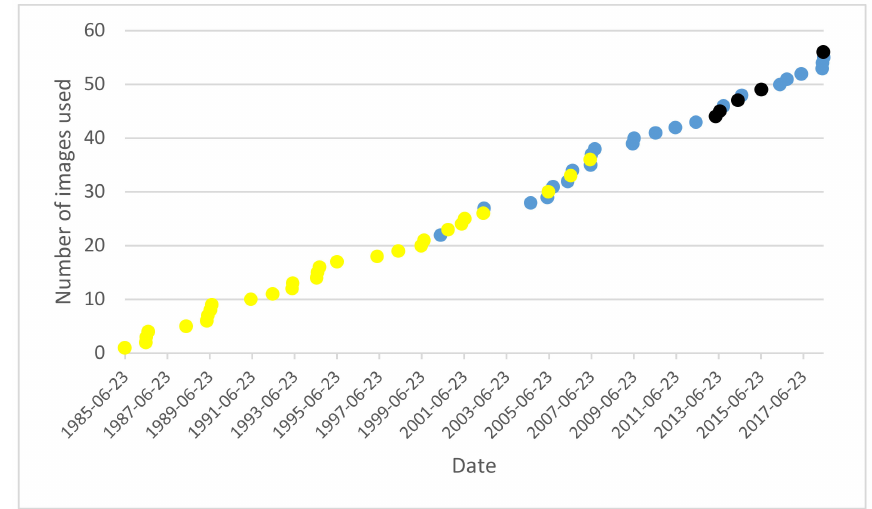
Figure 2. The sensor types and dates of Landsat imagery used in this study. Yellow dots represent Landsat 5, blue dots represent Landsat 7, and black dots represent Landsat 8